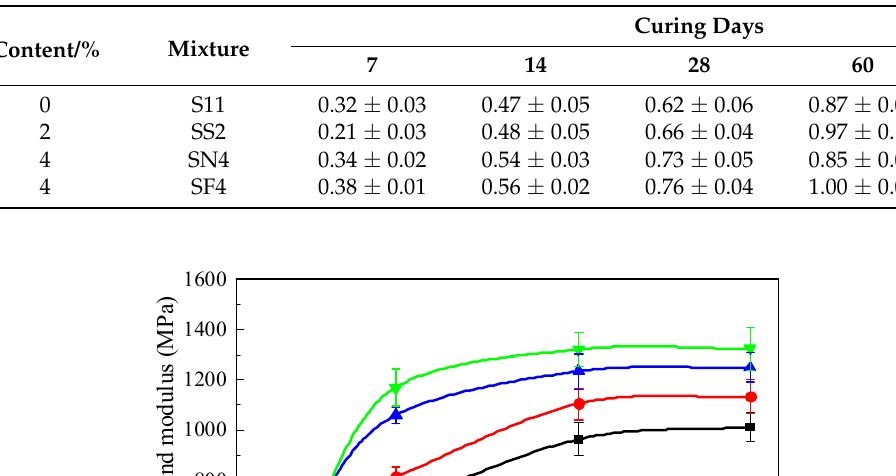
Table 6. Test results for flexural strength (MPa).